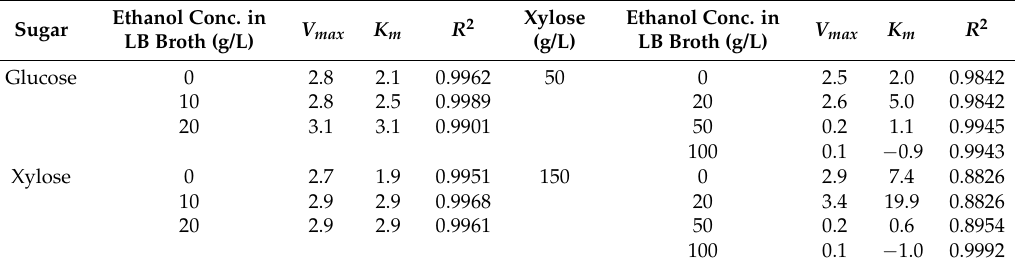
Table 4. Monod nonlinear parameters, as predicted by Hanes-Woolf